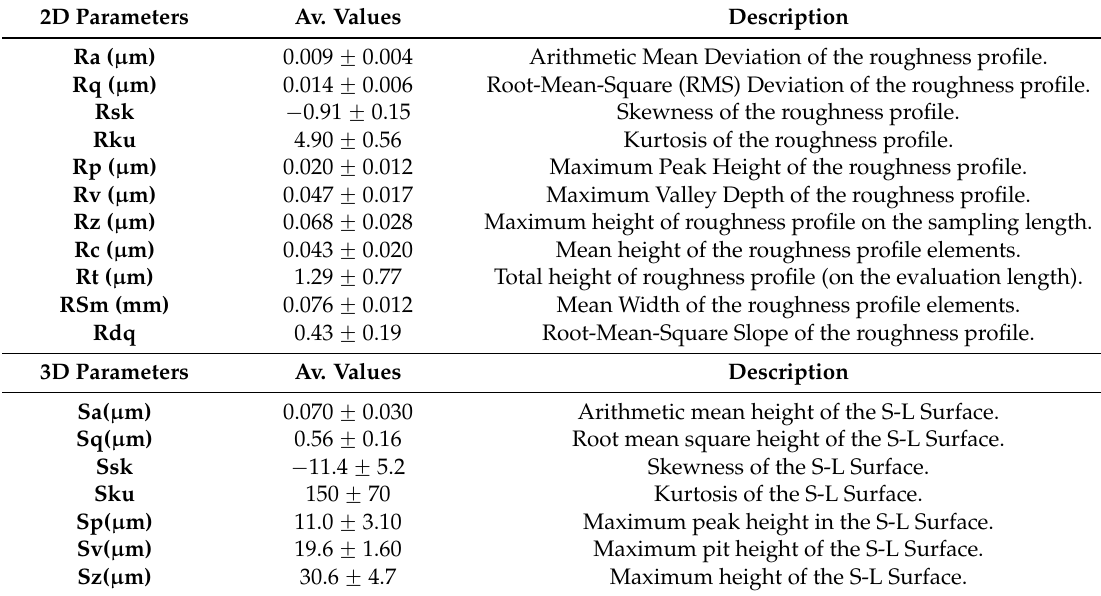
Table 2. Description and average (Av.) values of the measured two-dimensional (2D) and three-dimensional (3D) surface